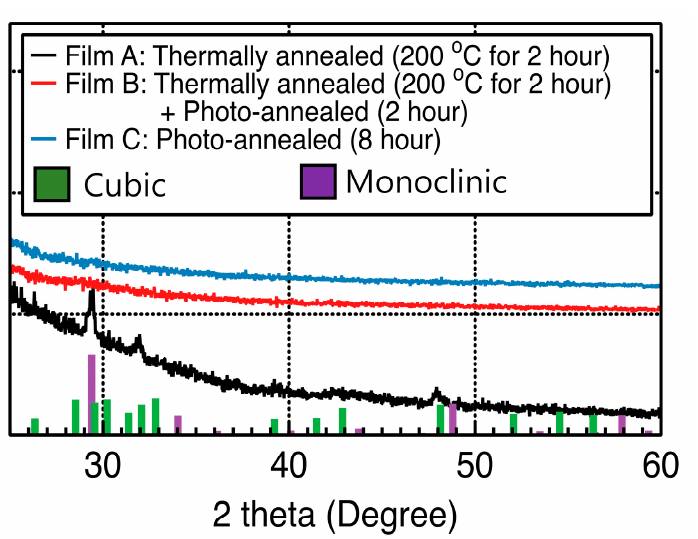
Figure 3. Grazing incidence X-ray diffraction spectra of Y 2 O 3 films obtained under different annealing treatments.